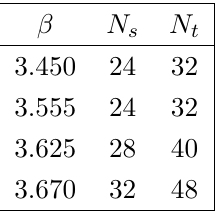
Table 1 . Bare parameters of our T (cid:25) 0 ensembles.